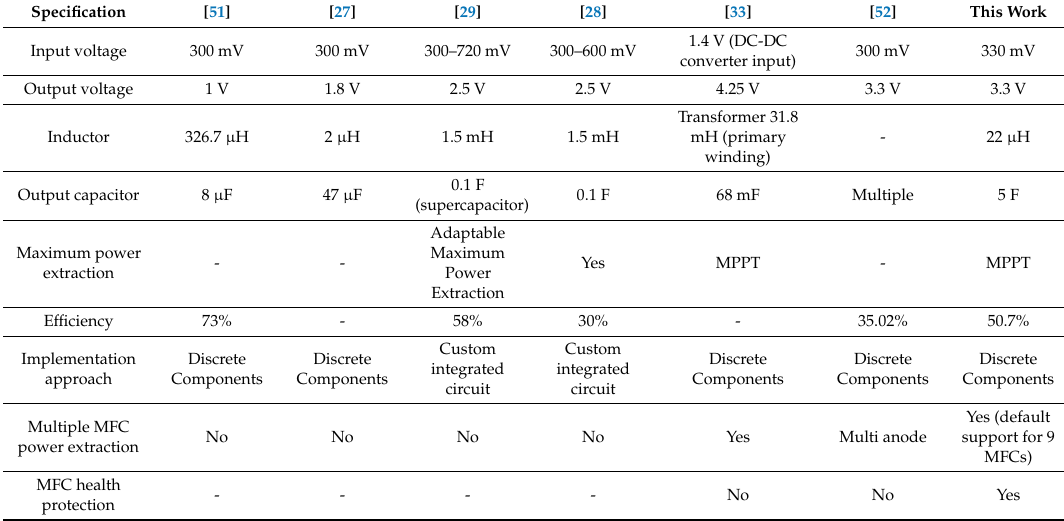
Table 4. Comparison of MFC power management